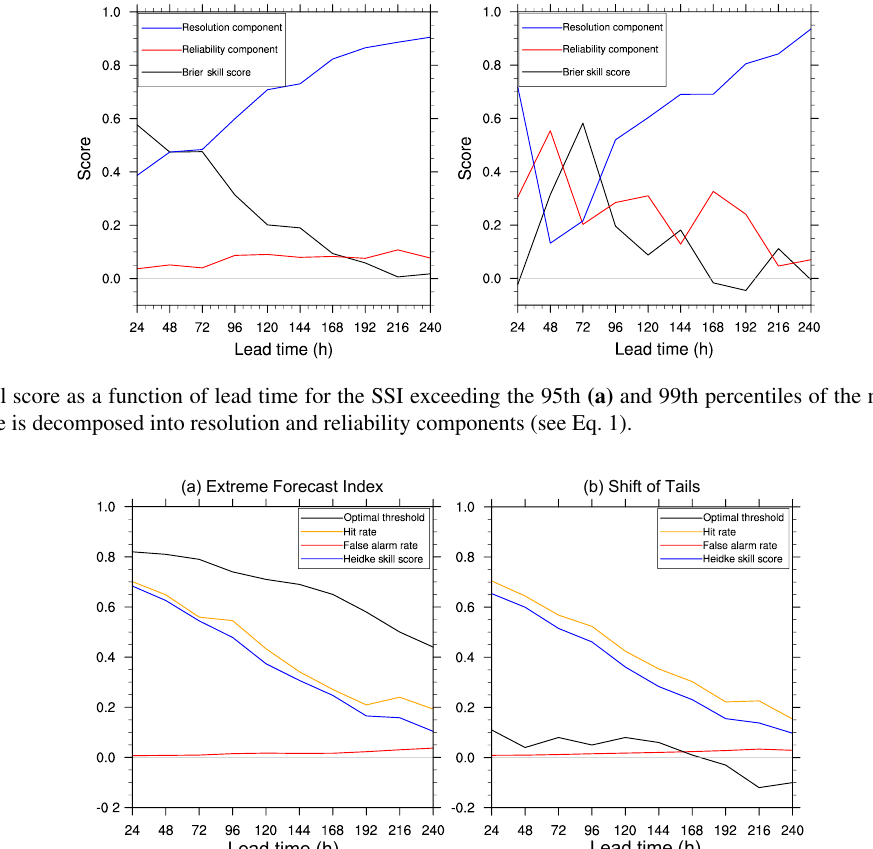
old increasing or decreasing both H and F . Boisserie et